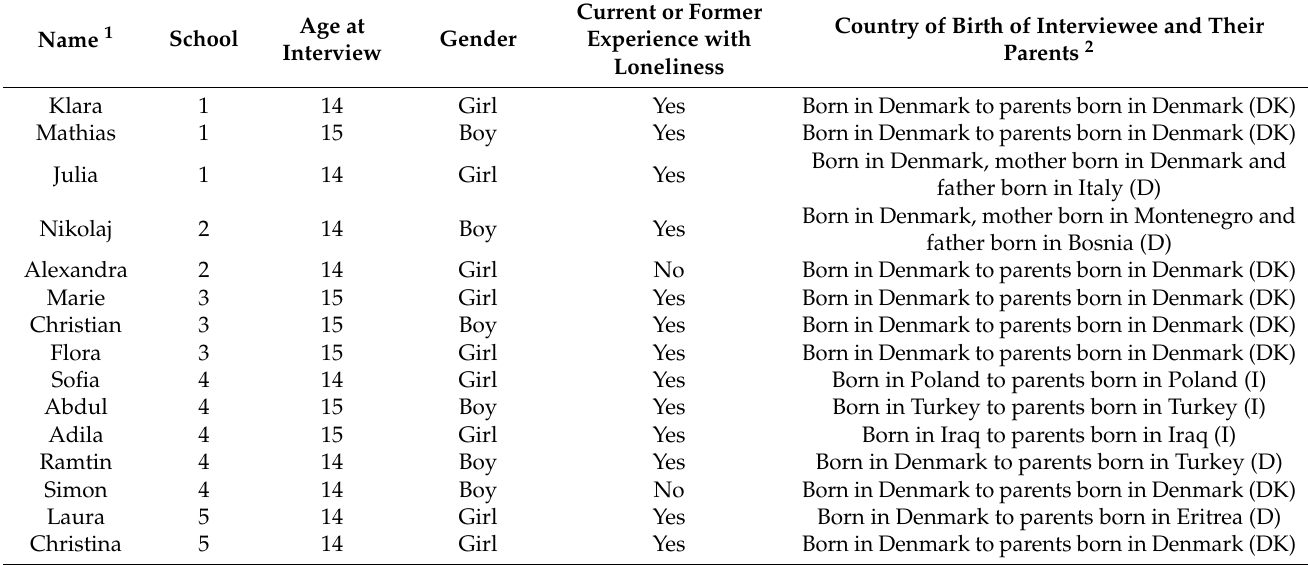
Table 1. Characteristics of